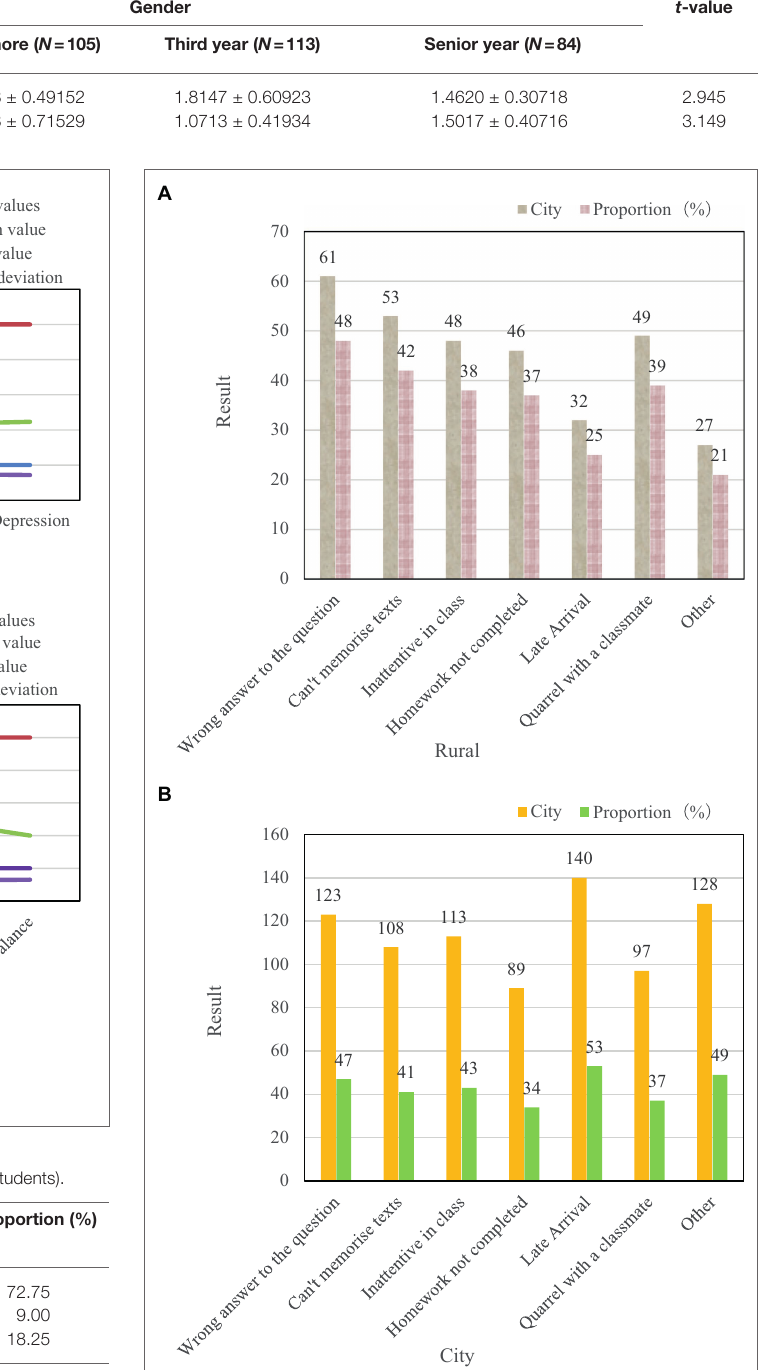
TABLE 6 | Students’ attitudes toward